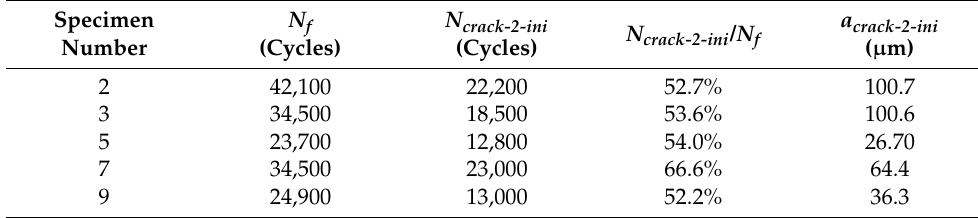
Table 4. Test data of cruciform specimen with the second